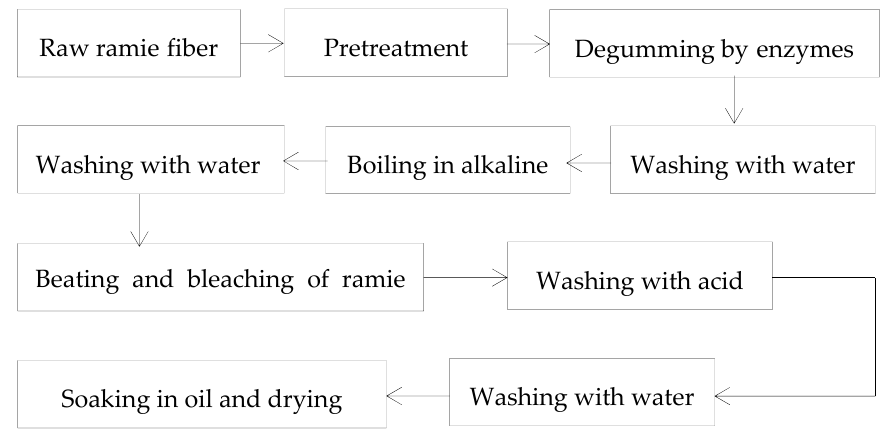
Figure 2. Typical enzymatic degumming processes of ramie fiber.